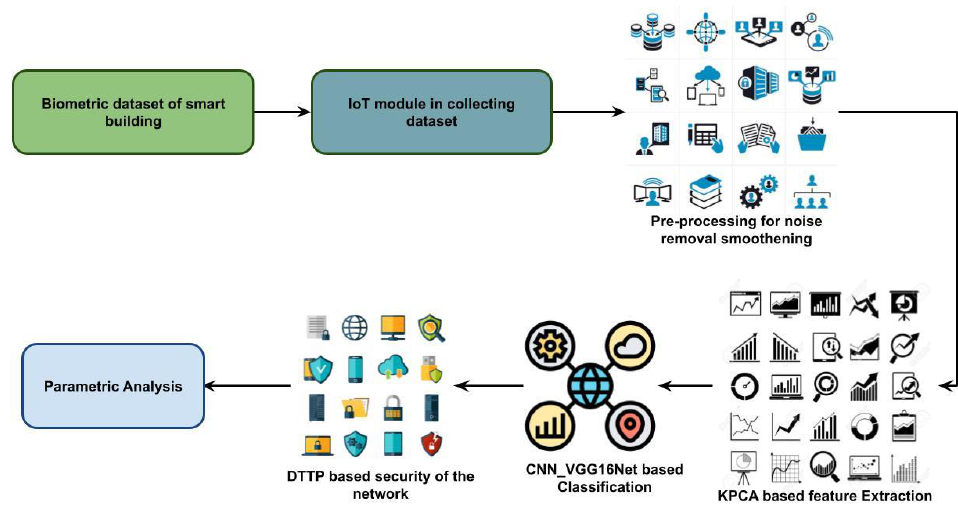
Figure 1. Overall proposed architecture.